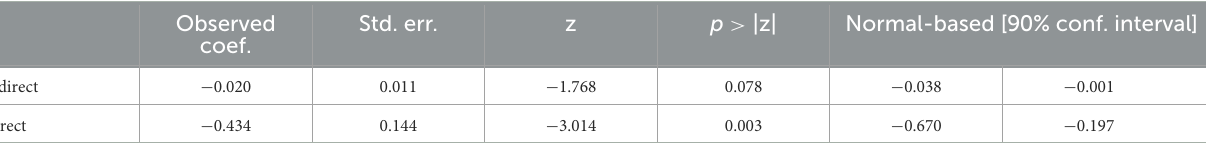
TABLE 4 Mediating test.